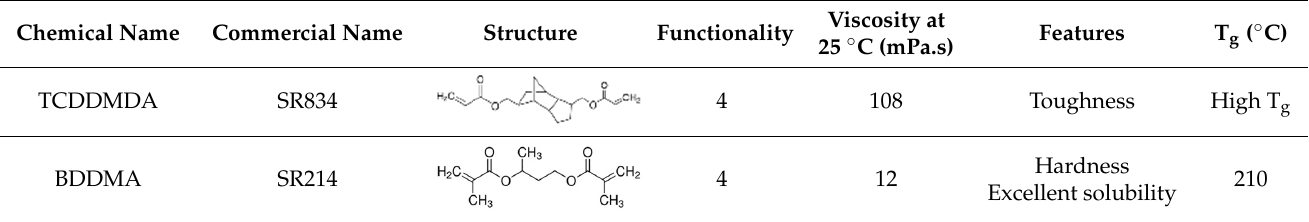
Table 3. Physical properties of acrylic-based multifunctional methacrylate